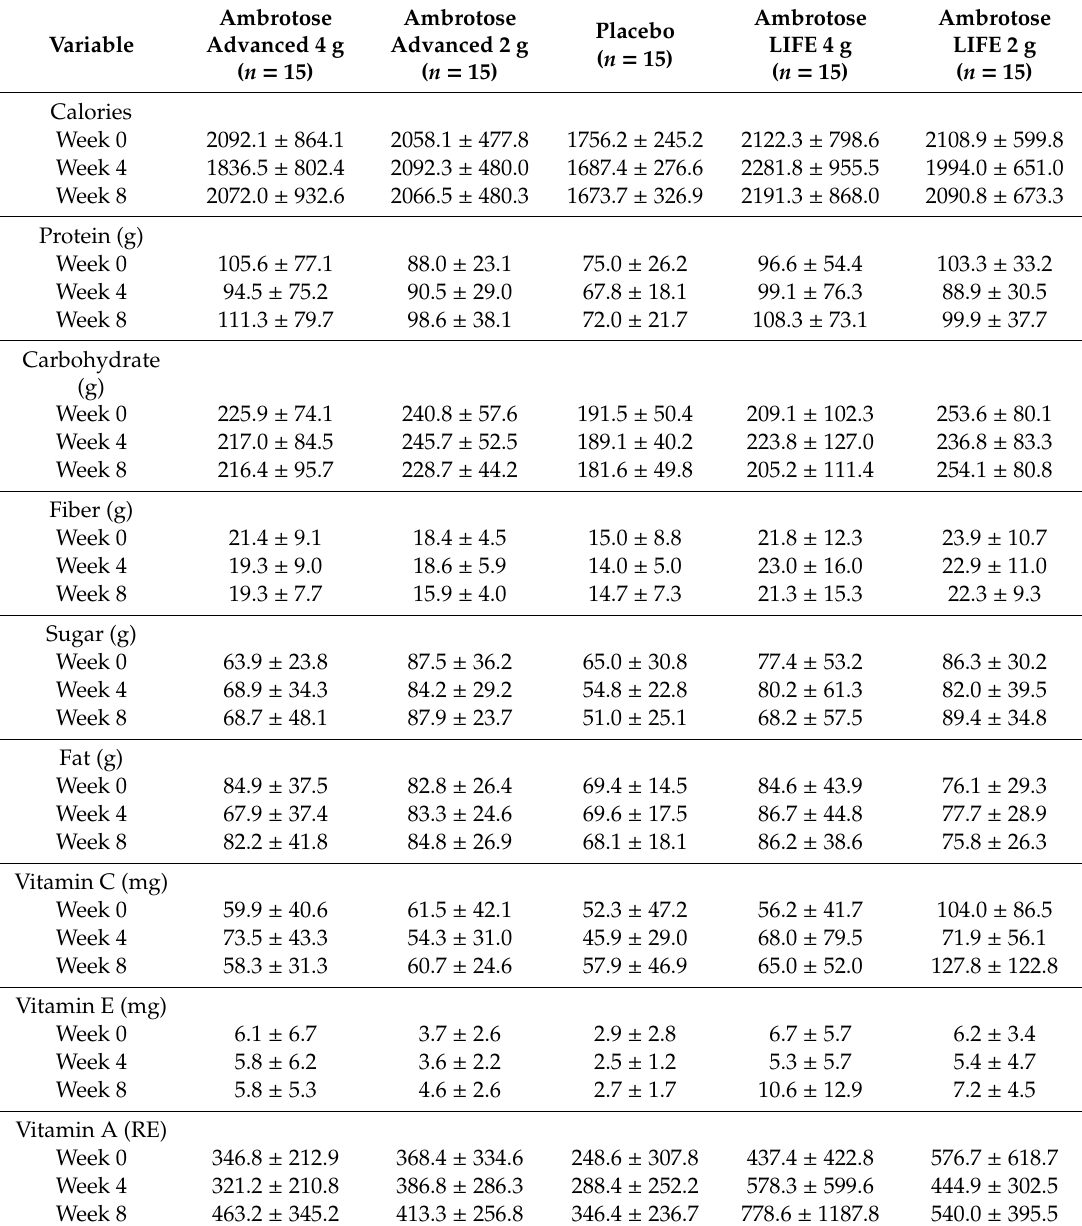
Table 2. Dietary data of 75 healthy men and women during the five days prior to each test